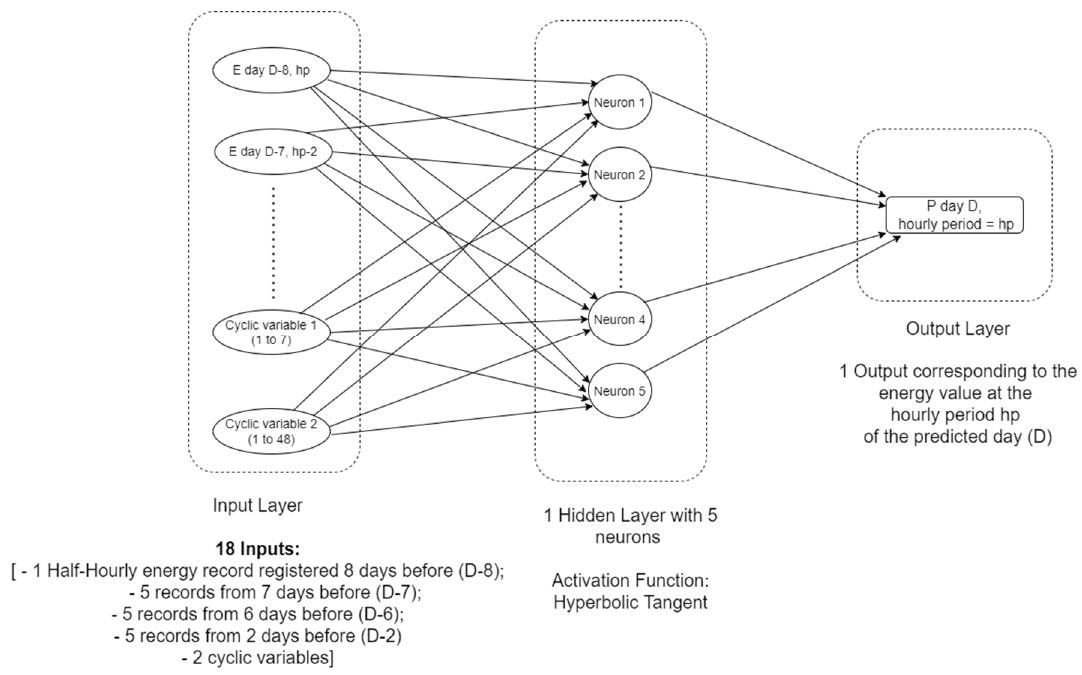
Figure 3. Example of a trained ANN model with 5 neurons in the hidden layer.